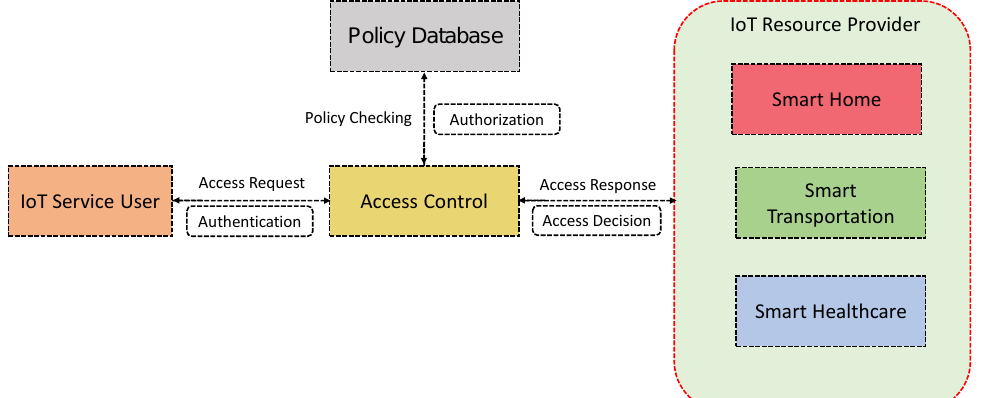
Figure 1. A typical outline of IoT access control